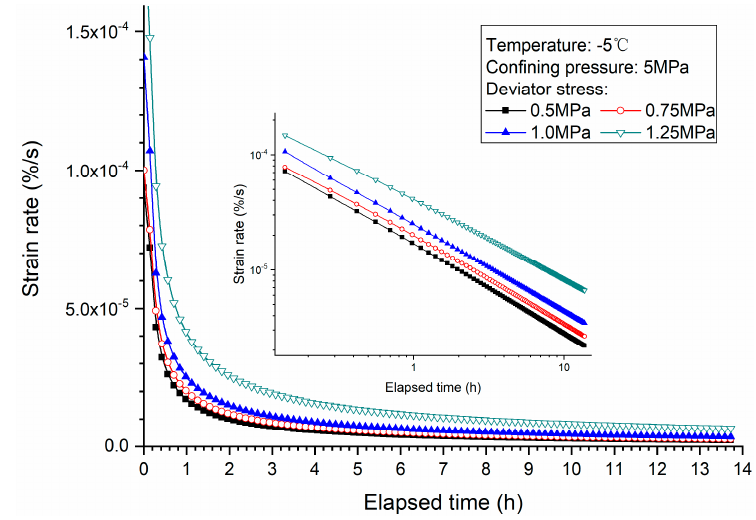
Figure 3. Creep strain rate versus elapsed time for methane hydrate-bearing frozen specimens under low deviator stresses.